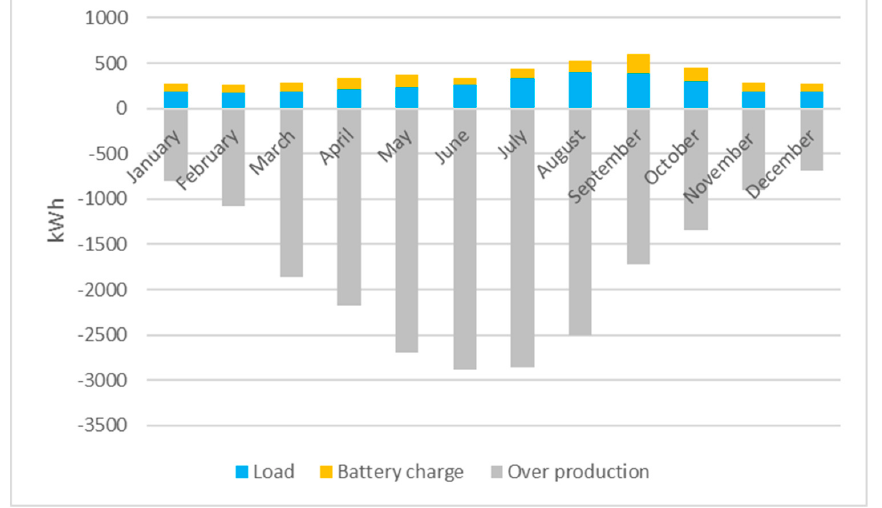
Figure 9. Energy flows for the stand-alone PV configuration (case a ).